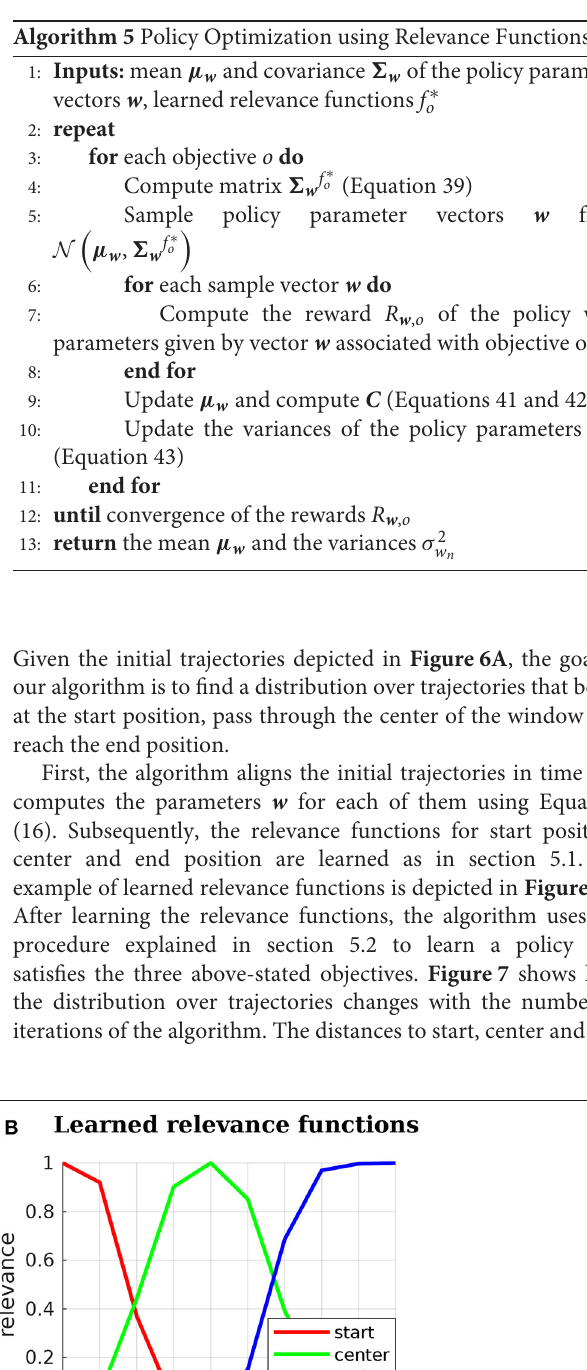
Frontiers in Neurorobotics |